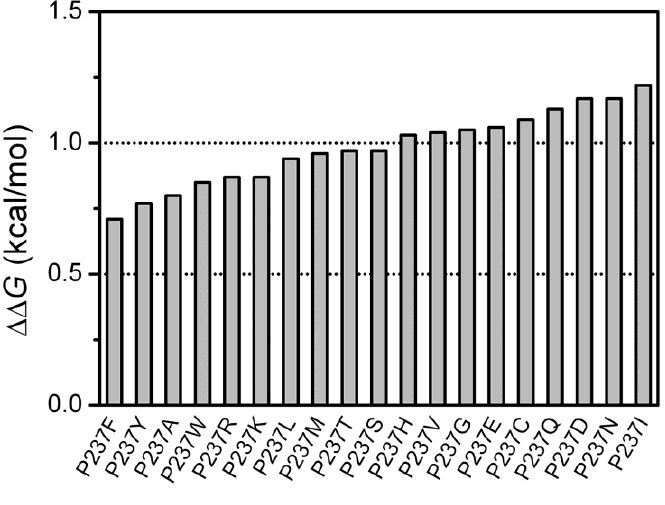
Figure 2. The changes in the Gibbs free energy induced by mutations predicted by FoldX.